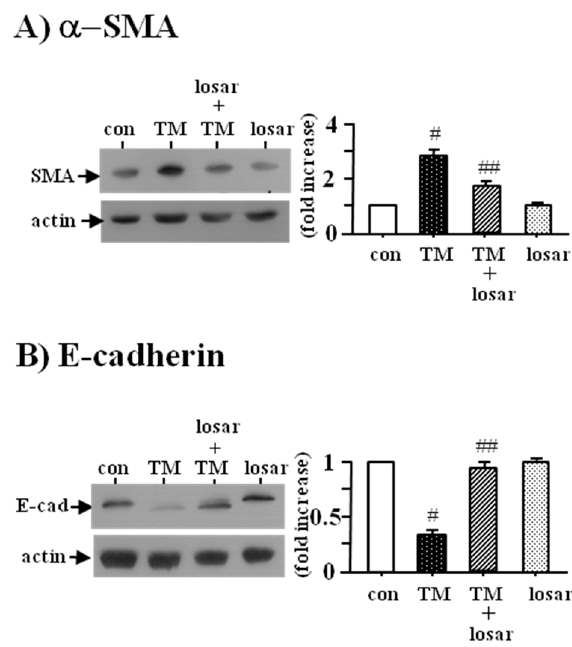
Figure 5. Inhibition of tunicamycin-induced epithelial mesenchymal transition by losartan. Proximal tubular cells were incubated with tunicamycin (TM, 0.2 µ M) with or without losartan (losar, 10 µ M) for 24 h. Expression of α -SMA ( α -smooth muscle actin) ( A ) and E-cadherin ( B ) was examined by Western blot analysis. The relative densities of the bands for α -SMA and E-cadherin were normalized to those for actin for standardization. Representative blots and quantitative analysis from three independent experiments were shown. Results were expressed as n -fold increase over control as mean ± S.E. #: p < 0.05 vs. con (control); ##: p < 0.05 vs. TM.